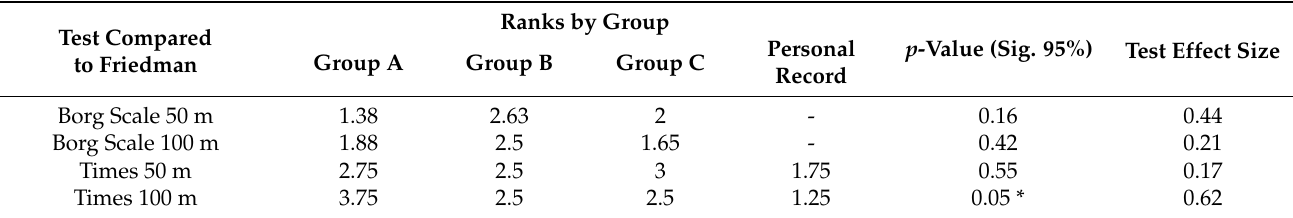
Table 5. Results of the Friedman test. Range and p -value are shown to a significance of 95% by variable and distance. Test effect size calculated with Kendall’s W value. Ranks by Group Test Compared p -Value (Sig. 95%) Test Effect Size Group